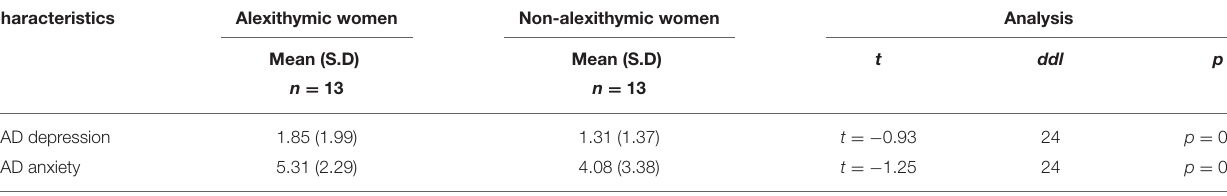
TABLE 1 | Scores of HADS for anxiety and depression of alexithymic women vs. non-alexithymic women (1-year later). Characteristics